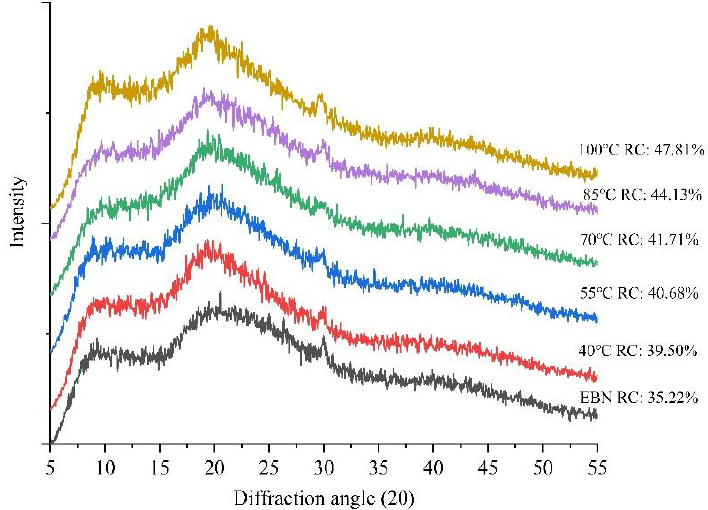
Figure 7. X-ray diffraction of the insoluble fractions.